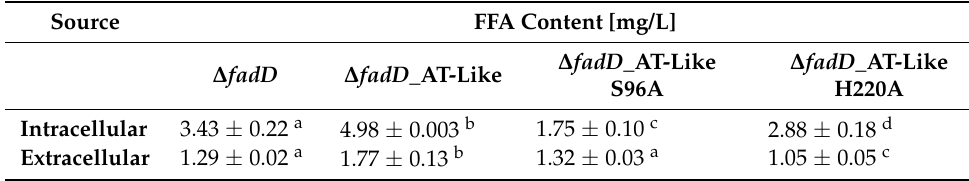
Table 3. Free fatty acid contents in ∆ fadD_ AT-likeS96A and ∆ fadD _AT-likeH220A. Values are reported as means ± standard deviations for three biological replicates. Means with different letters are statistically different according to a one-way ANOVA test ( p < 0.05) with multiple comparisons performed among intracellular and extracellular activities,